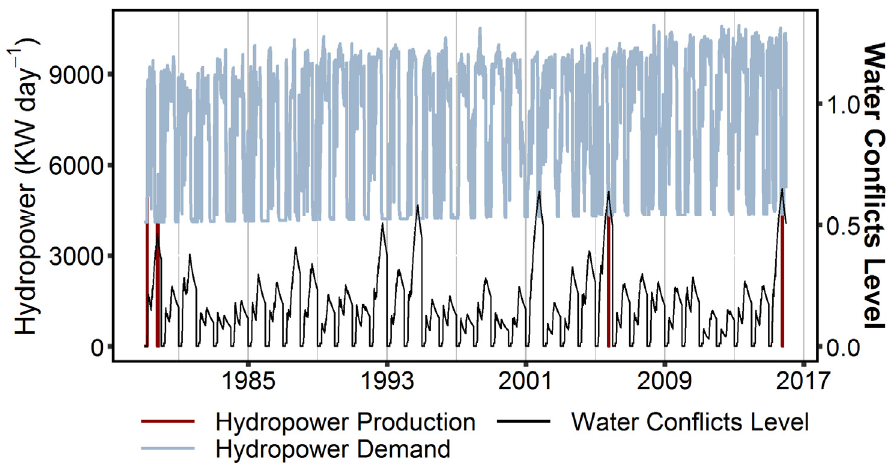
Figure A1. Hydropower demand, production, and water conflict level during 1979 to 2015.